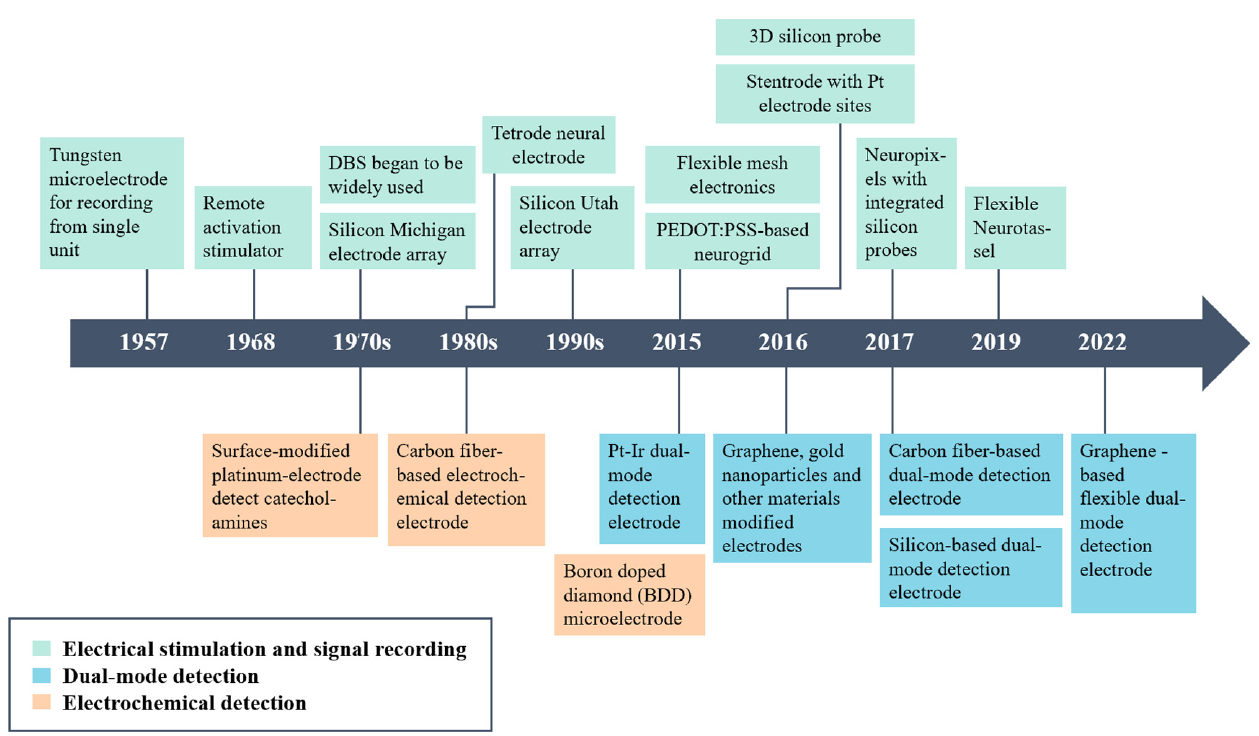
Figure 2. The development trend of various electrodes is indicated on the time axis [35,36,38–46].